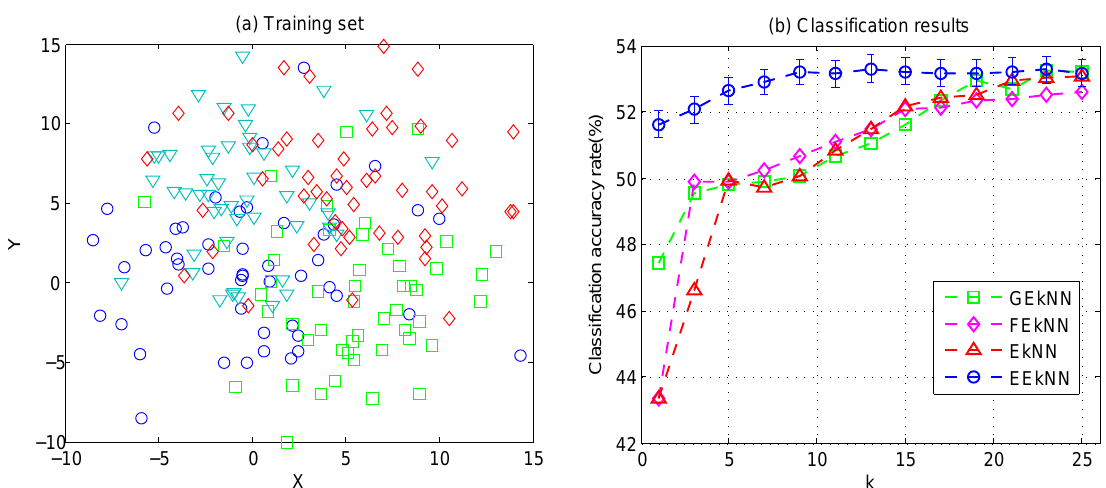
Figure 7. Training set and classification results for Case 3 with imprecision ratio ρ = 79%.